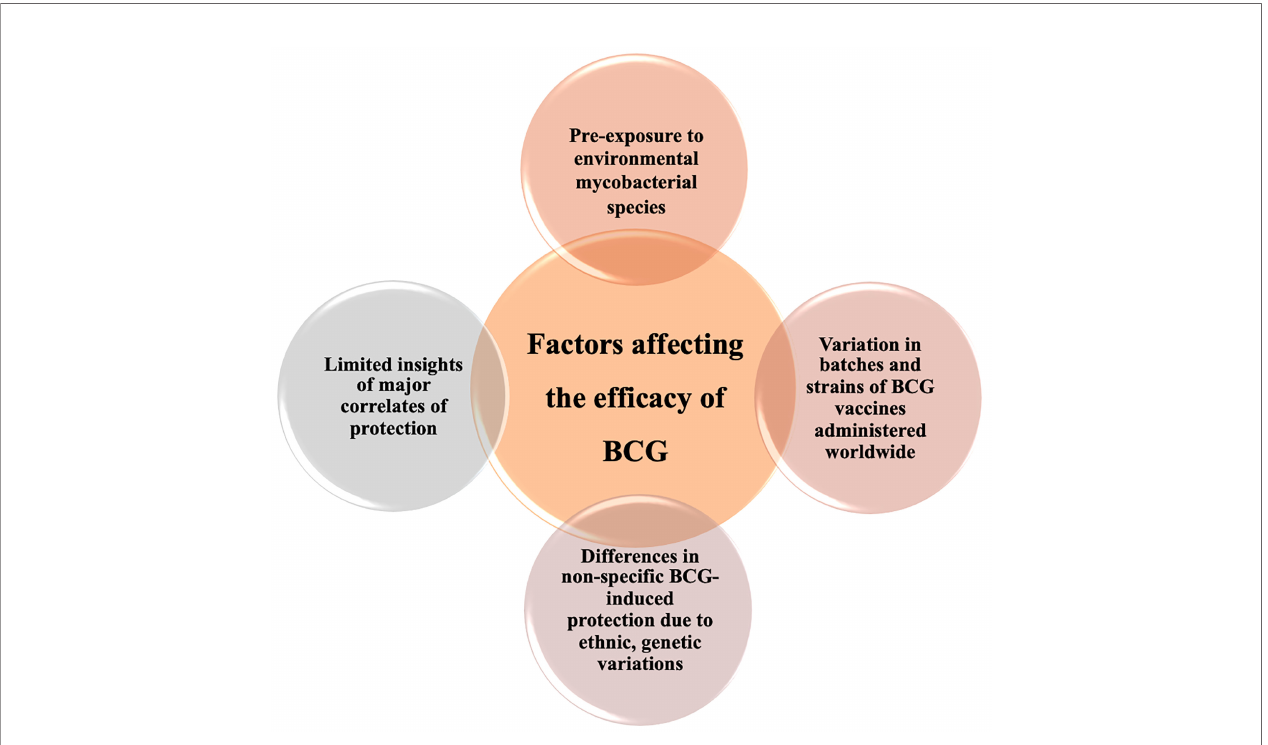
FIGURE 2 | Diverse factors associated with variable ef fi cacy of BCG. Inconsistent ef fi cacy of BCG vaccination can be linked to numerous host factors including genetics, geographical representation, ethnicity, and fragmentary immunological insight addition to variation in BCG vaccine strains with distinct